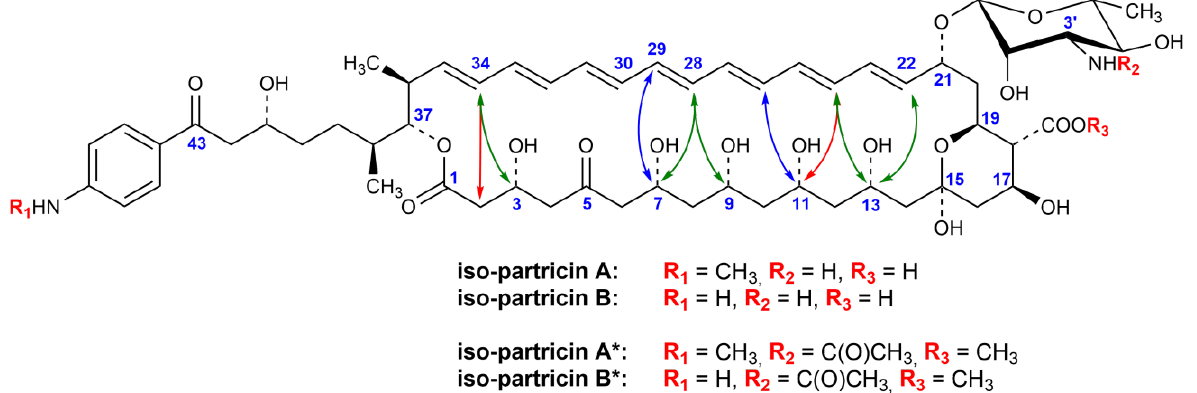
Figure 3. Structure of iso-partricins A and B, along with their methyl esters of N-acetyl derivatives. Dipolar couplings between the protons of the chromophores and the polyol chains are depicted as bidirectional arrows. Colors: blue—ROEs observed only for the native partricins [8,10]; green—ROEs observed for both native and isomeric partricins; red—ROEs observed only for the all-trans iso-partricins.